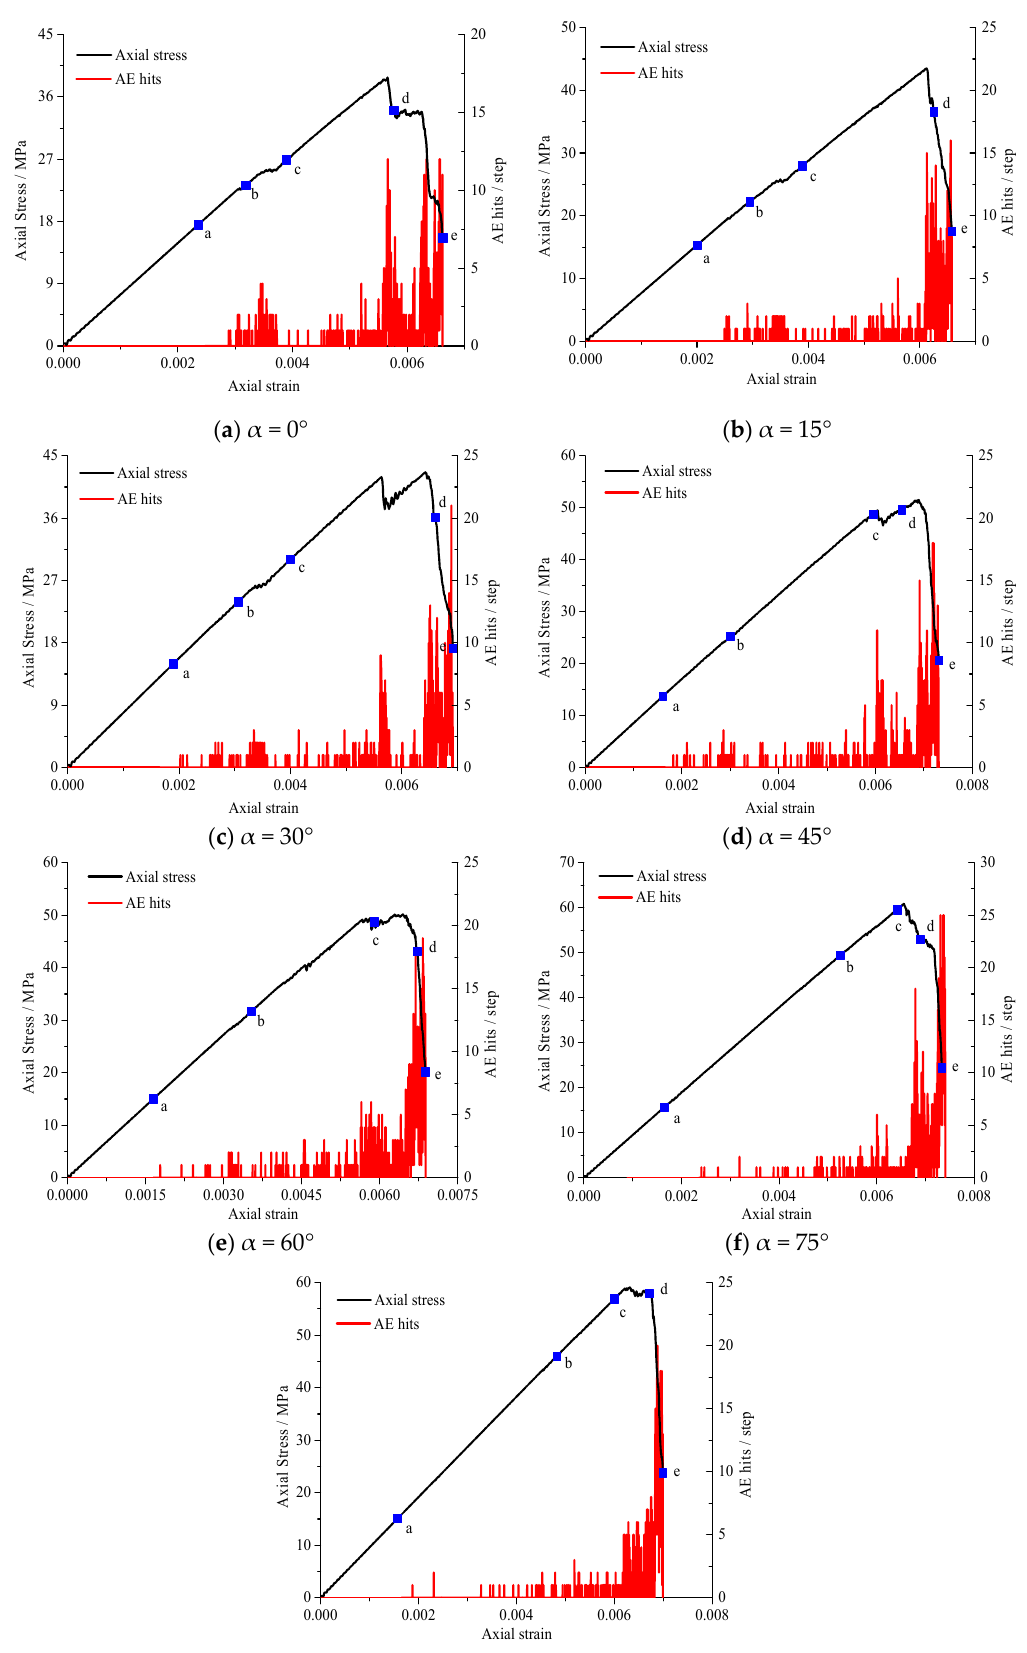
diagonal line of the model, and the model will eventually fail along the diagonal direction of the sample. At this time, the acoustic emission corresponds to point e in Figure 7.